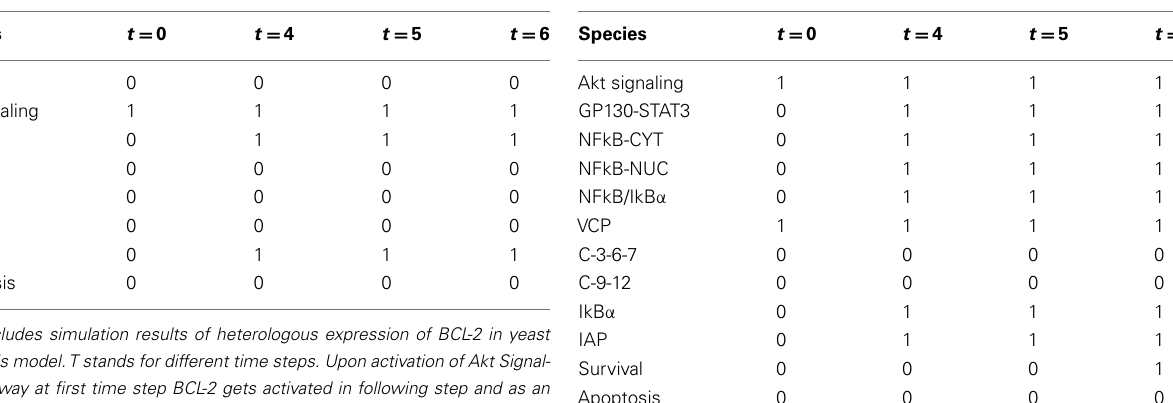
Table 5 | Summary of simulations upon insertion of Bcl-2 pathway. Table 6 | Summary of simulations upon insertion ofVCP pathway.